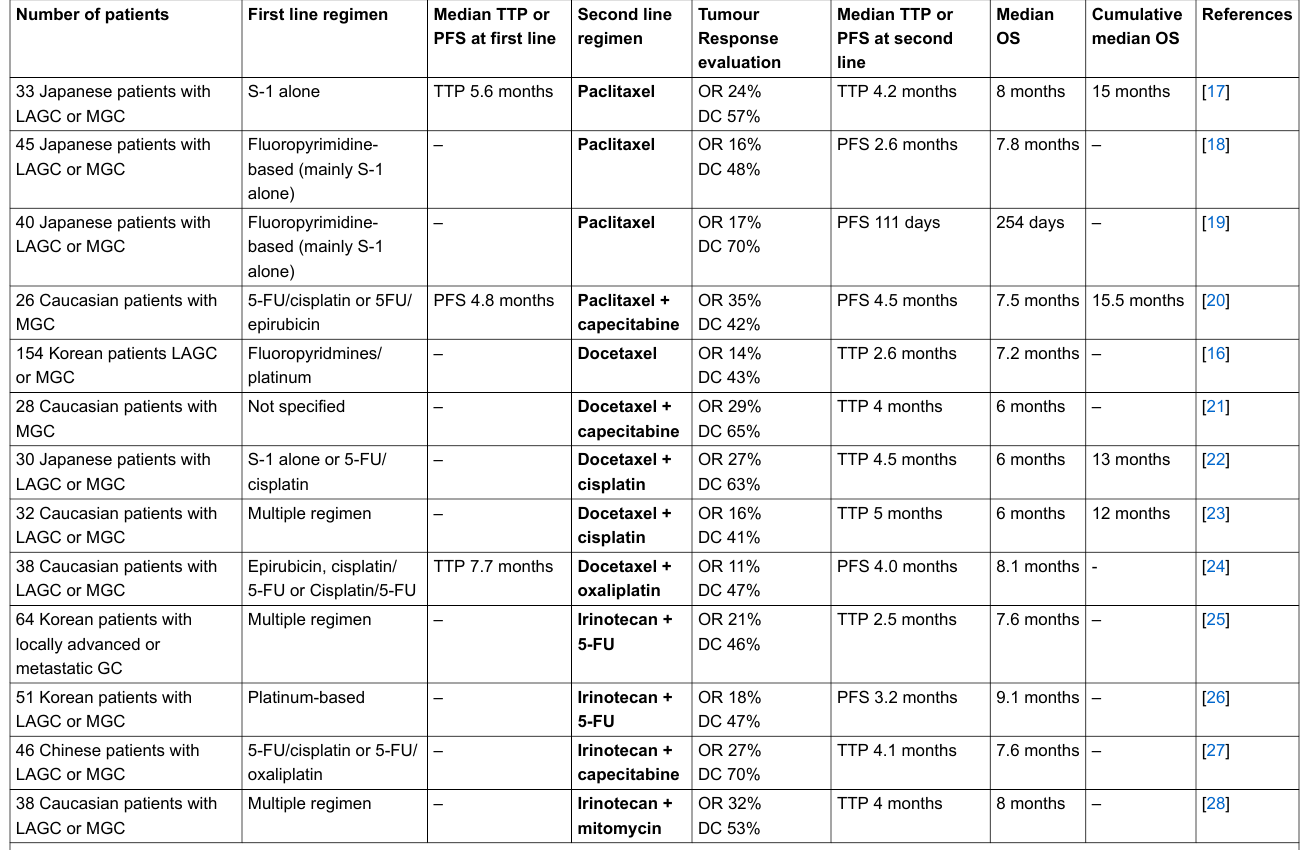
Table 1: Published phase II studies evaluating second-line chemotherapy in advanced gastric cancer. Number of